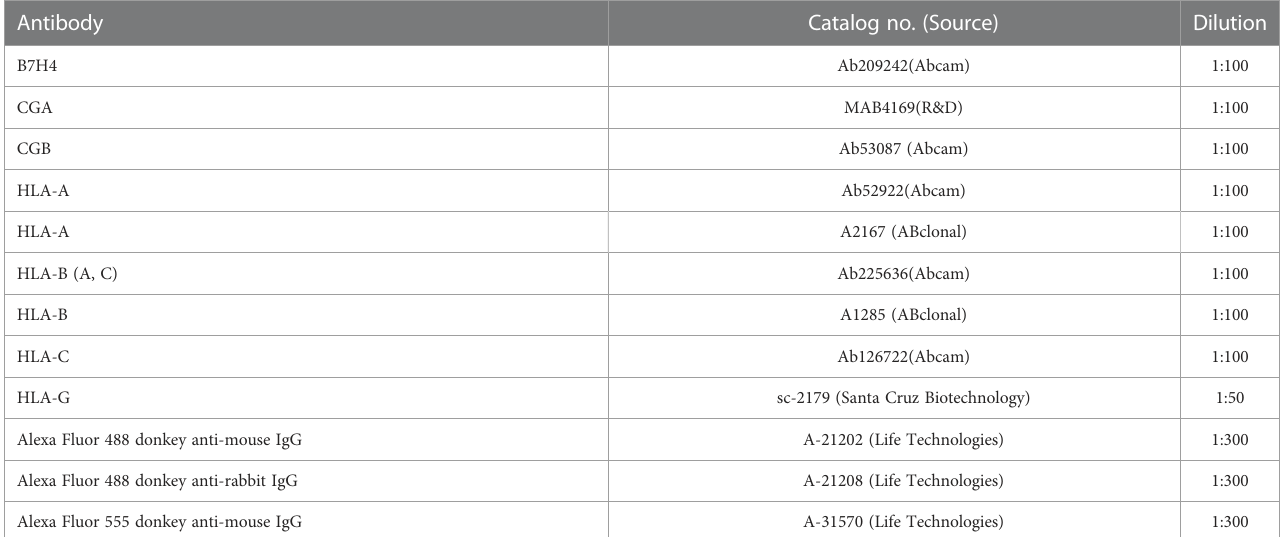
TABLE 2 Primary and secondary antibodies used in immunostaining. Antibody